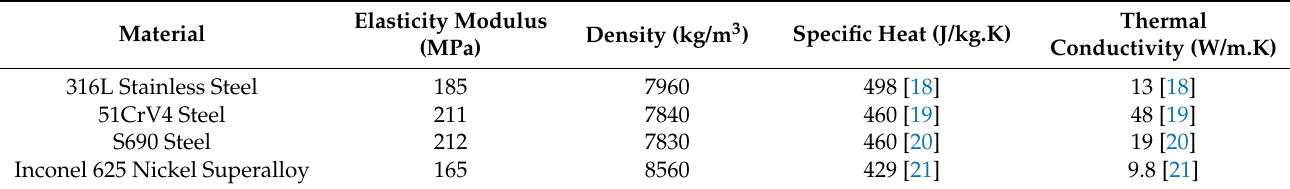
Table 1. Material properties for the studied UHCF specimens.